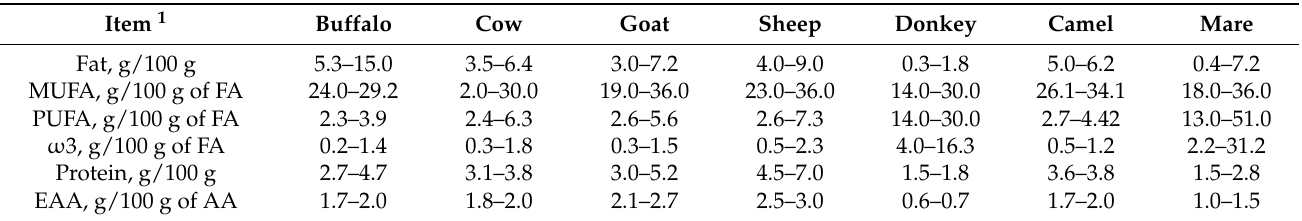
Table 1. Fat, protein, polyunsaturated fatty acids, and essential amino acids of cow, goat, ewe, donkey, camel, and mare in their raw milk